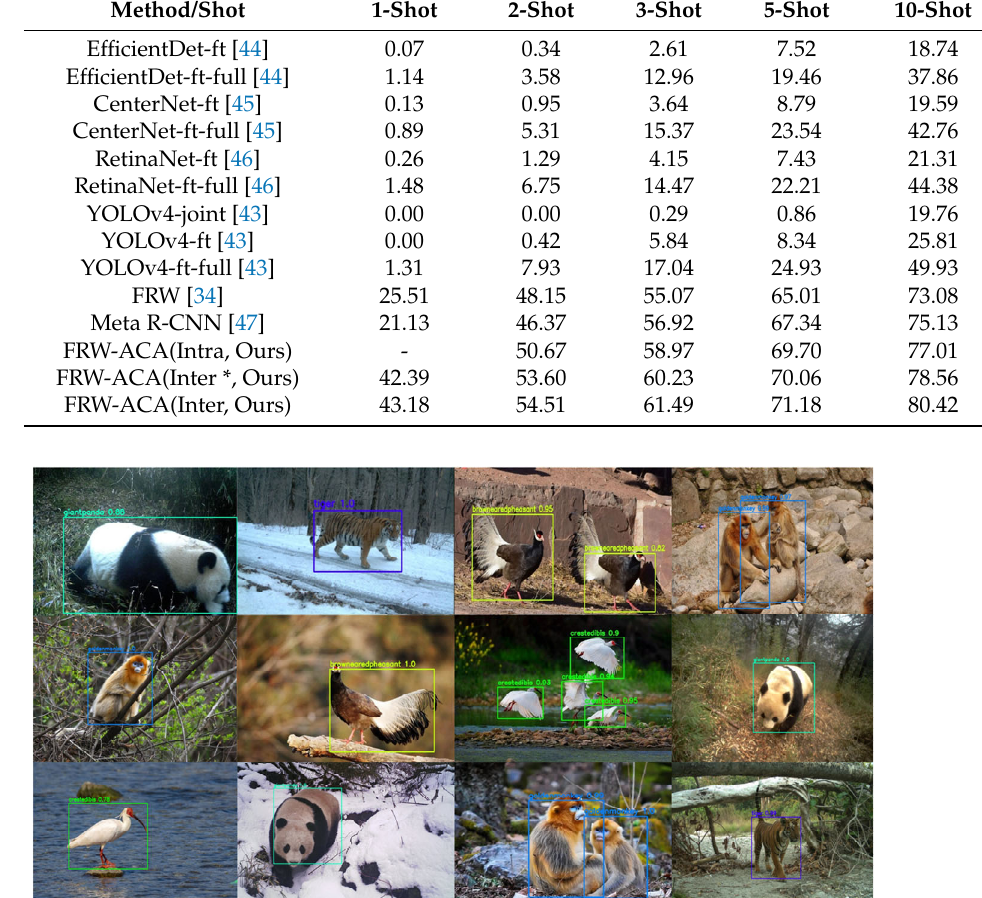
Figure 7. Precision–recall curves of our model and other baselines on the EAOD dataset. (* indicates remove spatial constraints in the mixture).